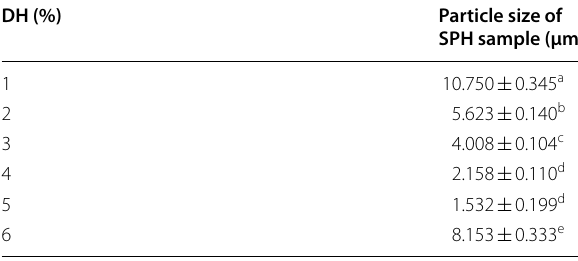
The results were expressed as the mean superscript letter are significantly different at p < 0.05